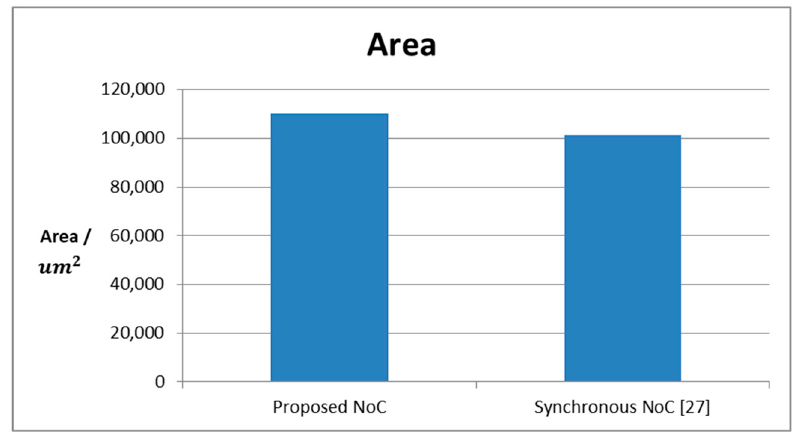
Figure 16. The area comparison for the proposed architecture vs. the fully synchronous architec- ture.